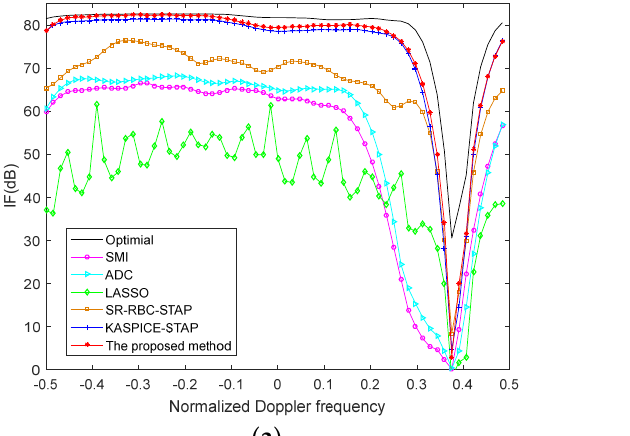
( d ) Figure 7. Clutter Angle ‐ Doppler capon spectrums estimated by different methods in the non ‐ ideal condition with ICM: ( a ) the ideal CNCM; ( b ) SMI; ( c ) KASPICE ‐ STAP; ( d ) the proposed method.